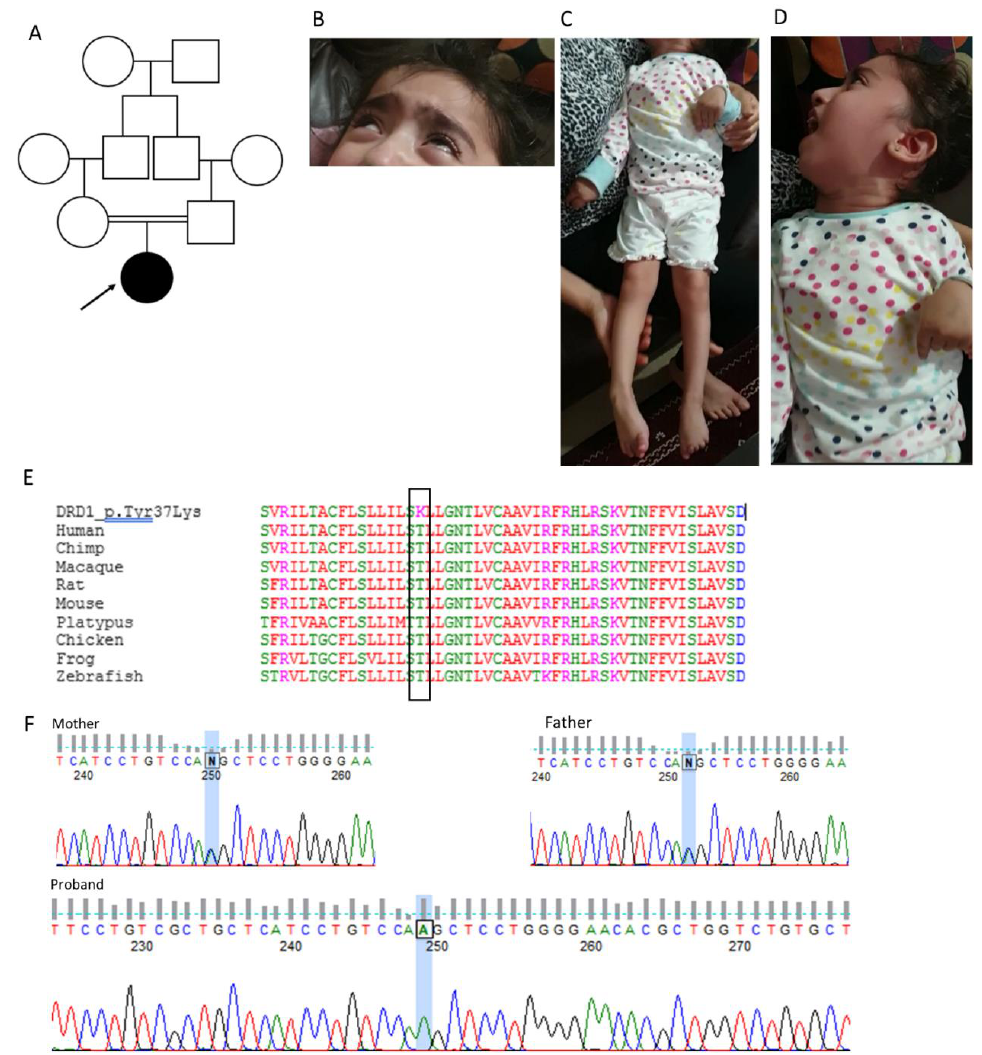
Figure 3. Clinical features and genetic findings in proband. ( A ) Family pedigree, with affected individuals indicated by black shading. ( B – D ) Images of proband aged approximately four years depicting phenotype. ( B ) Bilateral fixed upwards eye deviation during an oculogyric crisis. ( C ) Dystonic posturing of trunk and limbs; note striatal toe on the right. ( D ) Opisthotonic posturing and dystonic jaw opening. ( E ) Alignment of cross-species DRD1 protein sequences in human, chimp, macaque, rat, mouse, platypus, chicken, frog and zebrafish showing conservation of the amino acid and surrounding region. Black box indicates relevant amino acid. ( F ) Sanger sequencing analysis confirming the DRD1 variant. Sequence chromatograms show heterozygous variants at position c.110 in both parents, and a homozygous variant in